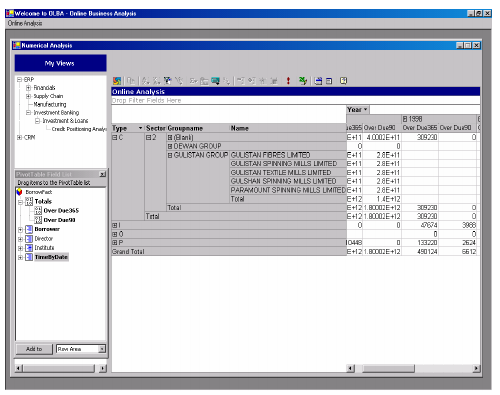
Figure 6: OLBA – Numerical Analysis